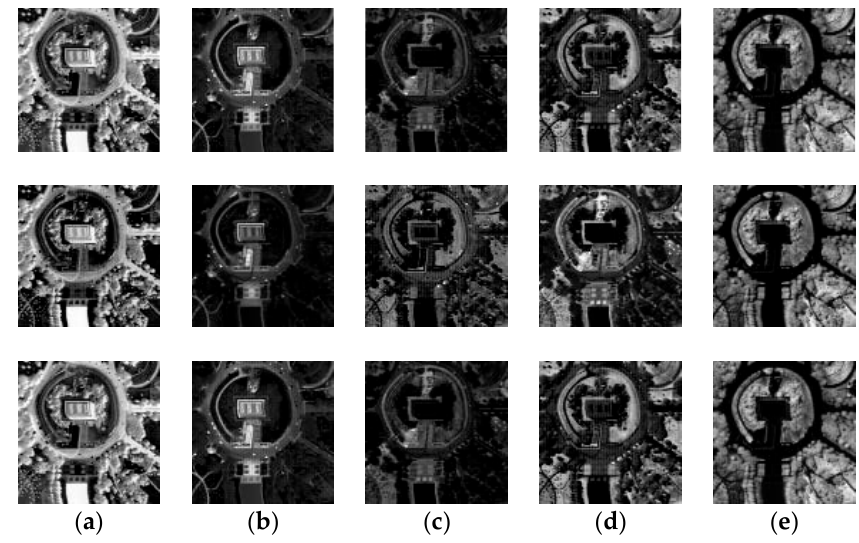
Figure 18. Abundance maps of HYDICE data estimated by BCNMF based on the FM, GBM, and PPNM, respectively, from top row to bottom row. Each column corresponds to the abundances of five